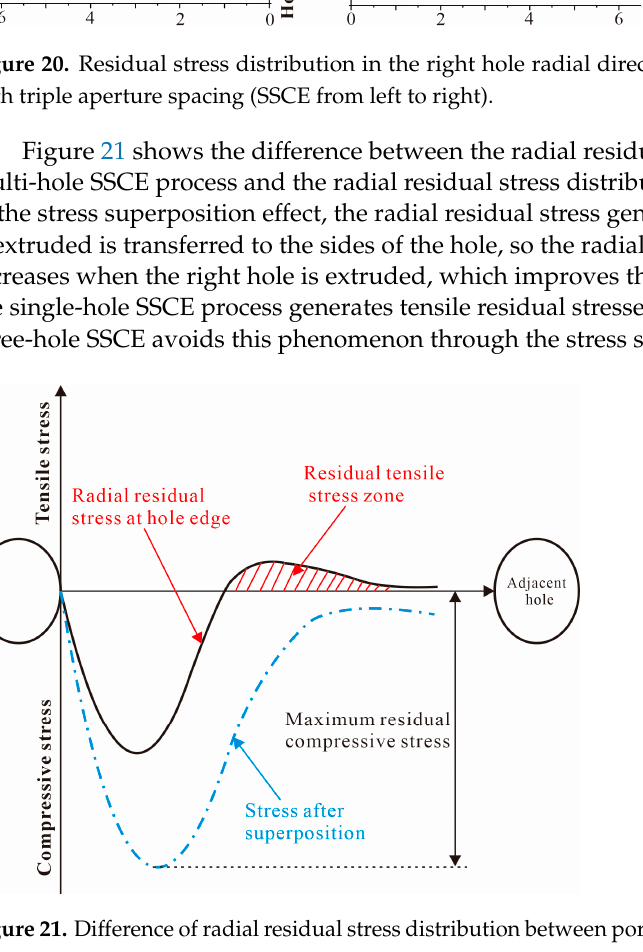
Figure 21. Difference of radial residual stress distribution between porous SSCE and single-hole